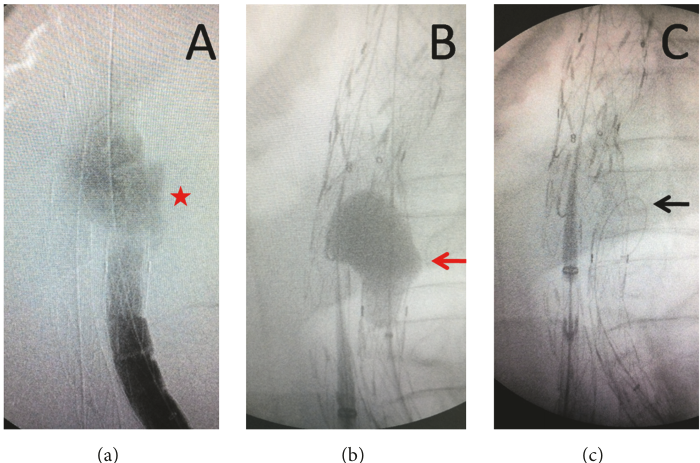
Figure 4: Contrast media continued to be visible outside the Talent endograft after the Ankura cuff deployment, restricted at the level of its bifurcation ((a), red star). Balloon inflation did not seal the endoleak; on the contrary, a fabric tear becomes apparent near the stent-graft bifurcation feeding the endoleak ((b), red arrow). A guide wire was passed through the fabric opening for verification ((c), black arrow).